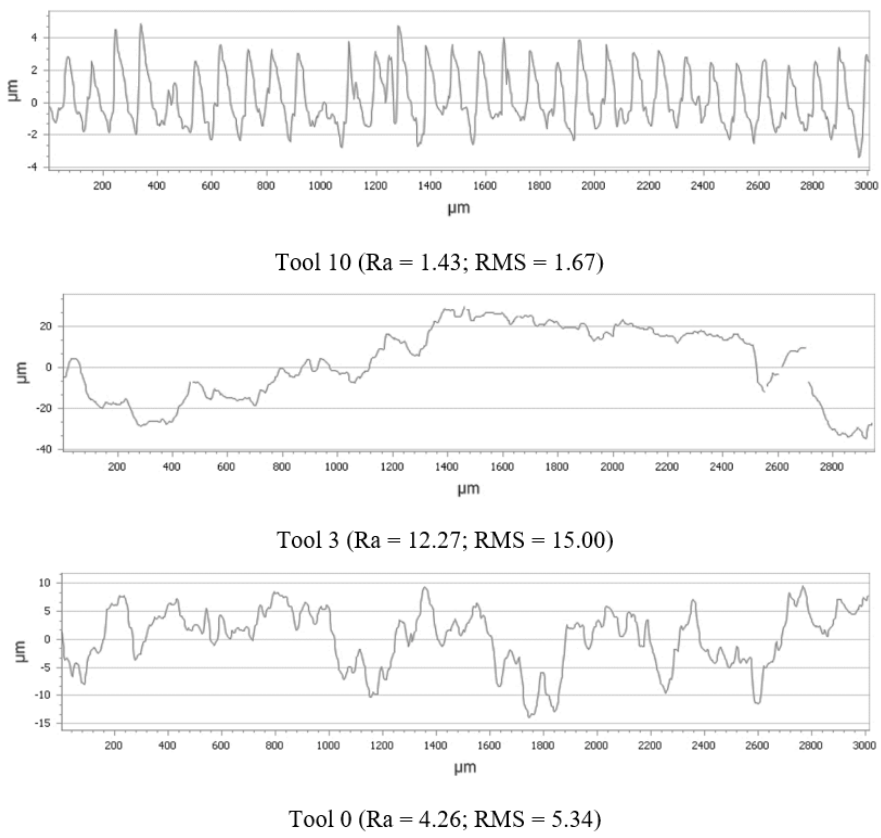
Figure 11. Surface roughness measurement for Tool 10, 3 and 0.